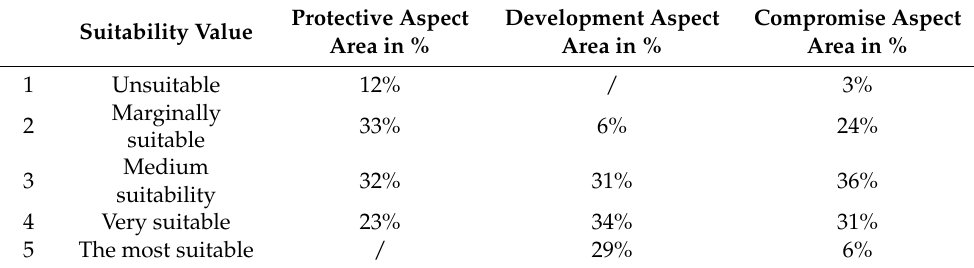
Table 5. A comparative view of the suitability value for bike and pedestrian path planning.